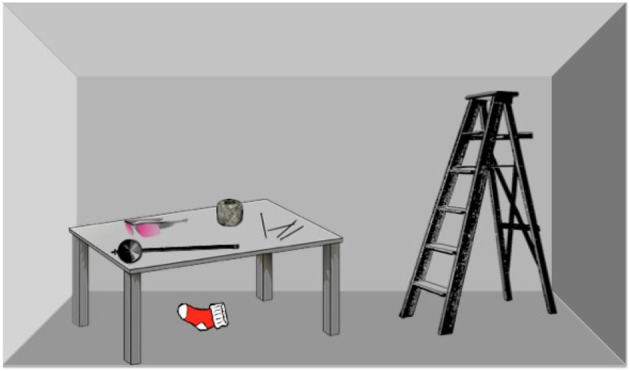
The weight problem.